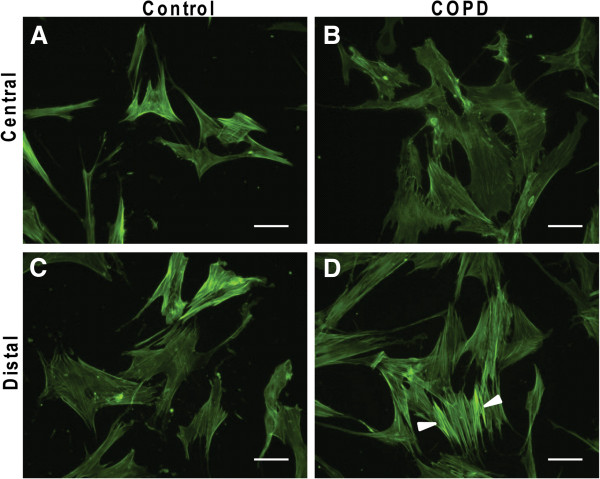
Stress fiber staining in isolated fibroblasts. Stress fibers were visualized in centrally (A and B) and distally (C and D) derived fibroblasts from control subjects (A and C) and COPD patients (B and D) by staining with phalloidin that binds to F-actin. Contractile cells have parallel fibers attached to their lamellipodia as is indicated by arrowheads in (D) Other cell types do not have this feature to the same extent. Scale bars represent 50 μm.